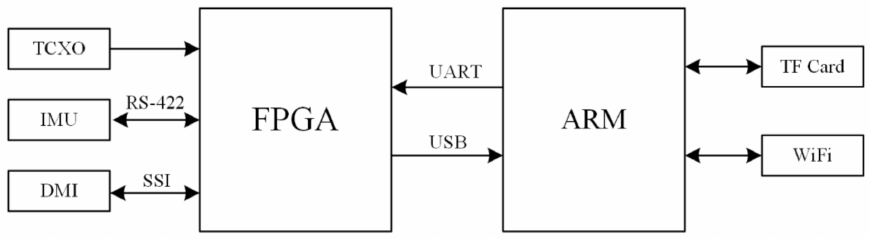
Figure 4. Framework of the multi-sensor integrated system.